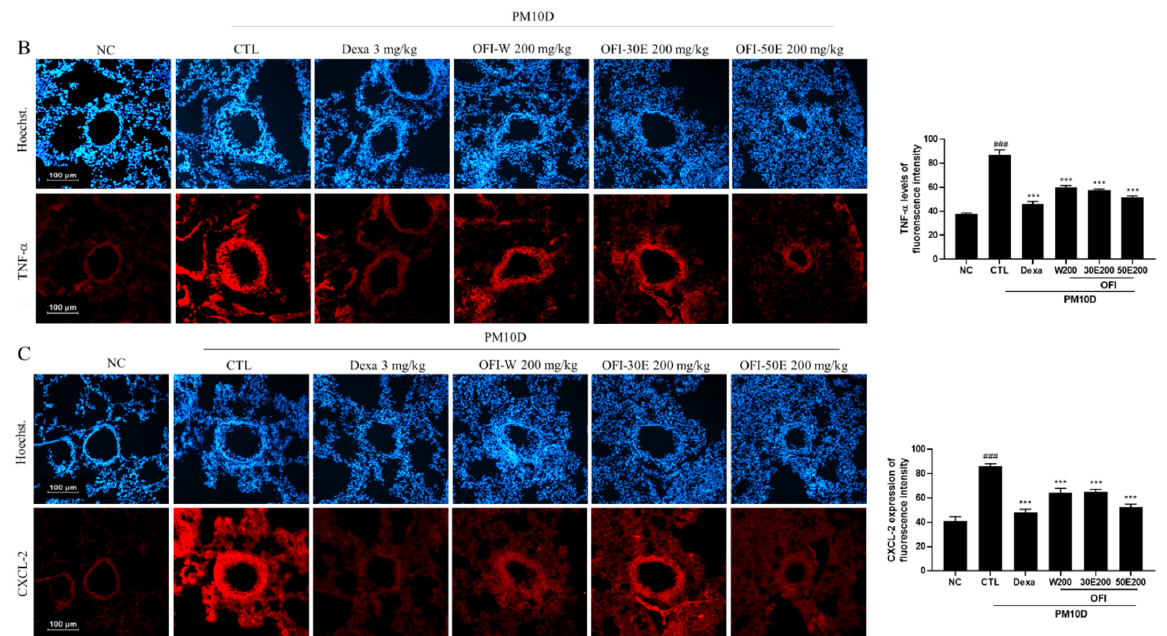
Figure 5. Immunofluorescence staining for interleukin-1 receptor-associated kinase 1 (IRAK1), TNF- α , and CXCL-1 protein expression in the lungs of mice with PM10D-induced airway inflammation. ( A ) IRAK1, ( B ) TNF- α , and ( C ) CXCL-1 expression in the lungs. NC: BALB/c normal control group; CTL: PM10D-induced control group; Dexa: 3 mg/kg dexamethasone-treated PM10D-induced